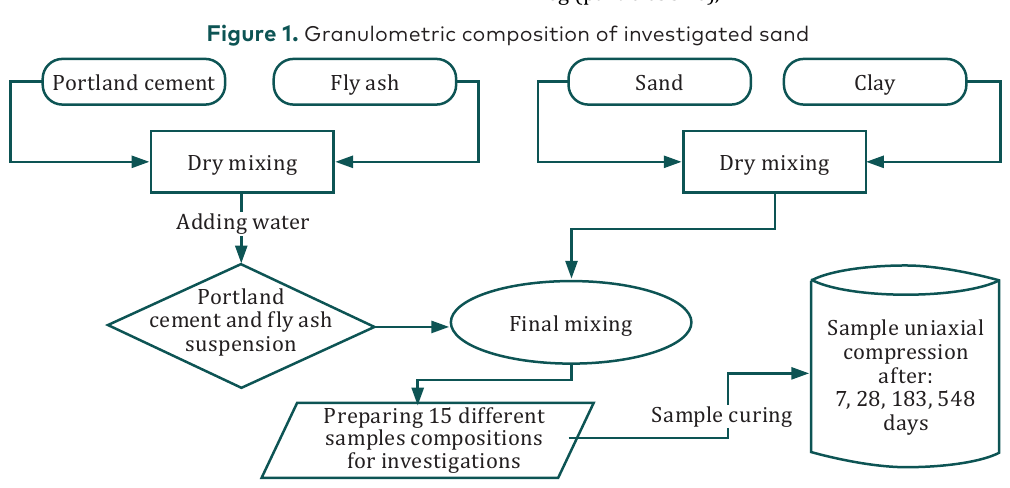
Figure 1. Granulometric composition of investigated sand